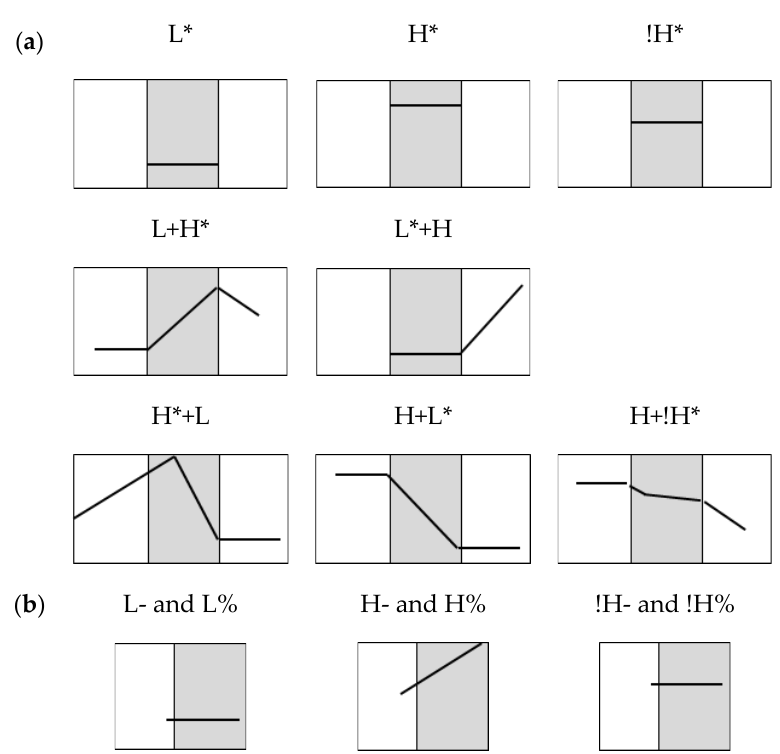
Figure A1. Schematized representation of a typical pitch contour labelled for ( a ) pitch accents and ( b ) edge tones. Boxes represent syllables; for pitch accents, the shaded box indicates the position of the accented syllable; for edge tones, the shaded box indicates the last syllable in the intermediate or intonational phrase.